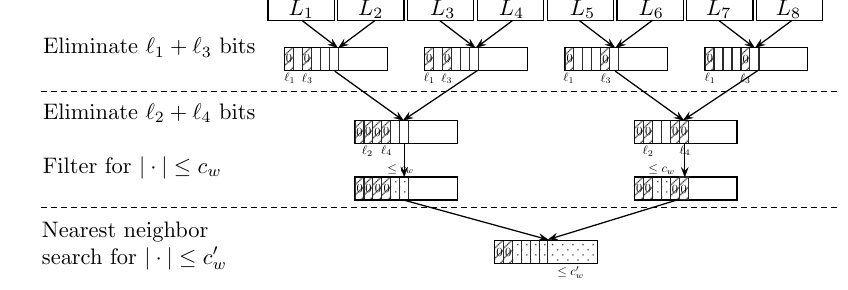
Figure 4: The Approximate k -List Algorithm, k =